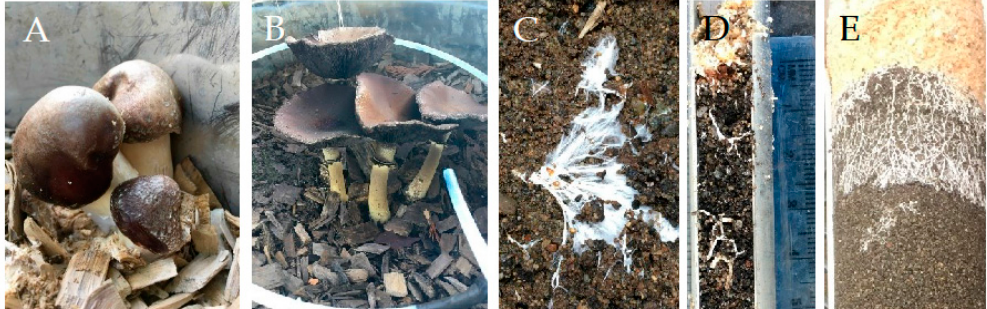
Figure 9. Growth of Stropharia rugoso-annulata . ( A , B ) Fruiting bodies emerged periodically over the study, confirming growth of the intended organism and verifying that the environmental conditions in the bioretention cell were conducive to its growth. ( C ) Mycelium growing on the BSM-mulch interface. ( D,E ) Root-like rhizomorphic mycelium extending down into the BSM both in the field as illustrated by the soil core ( D ) and in bench scale microcosms ( E ) made with the same materials (microcosm construction and photo credit: Maxwell Ledeig and Vesta Baumgartner; Mountlake Terrace High School).